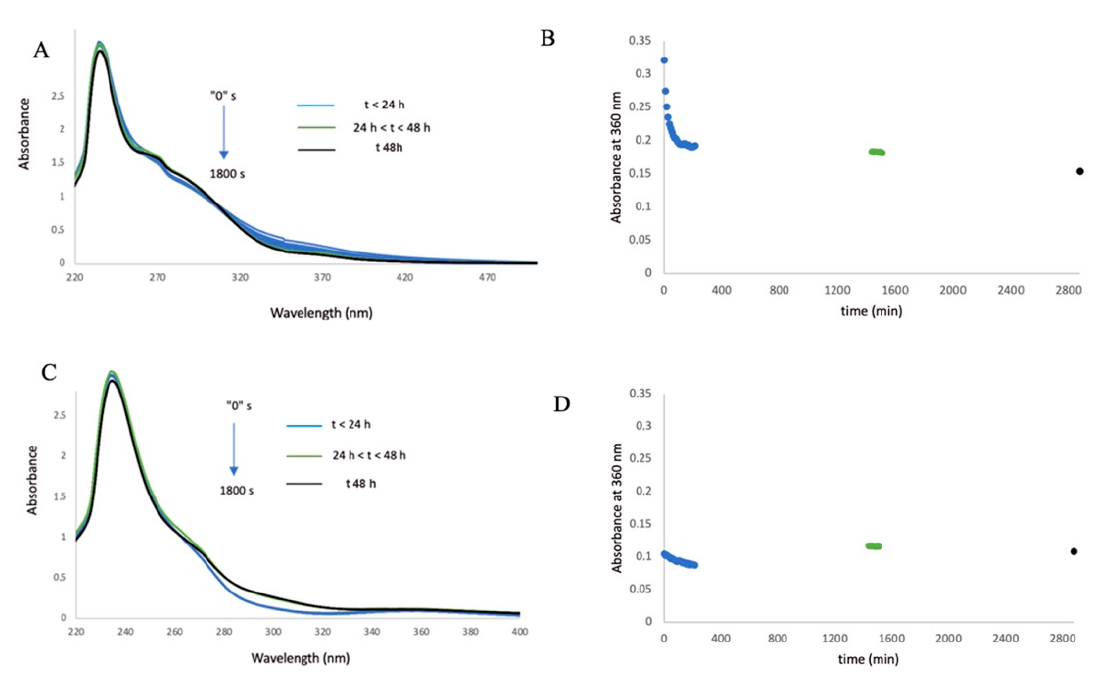
Figure 2. Time evolution of the UV–vis absorption spectrum of Fe1 ( A ) and Fe2 ( C ) in PBS buffer at pH 7 at room temperature under aerobic conditions. Variation of the absorbance, measured at 360 nm of Fe1 ( B ) and Fe2 ( D ). Blue colour indicates measurements made at t < 24 h, green colour indicates measurements at 24 h < t < 48 h, and black colour indicates measurements at t 48 h.